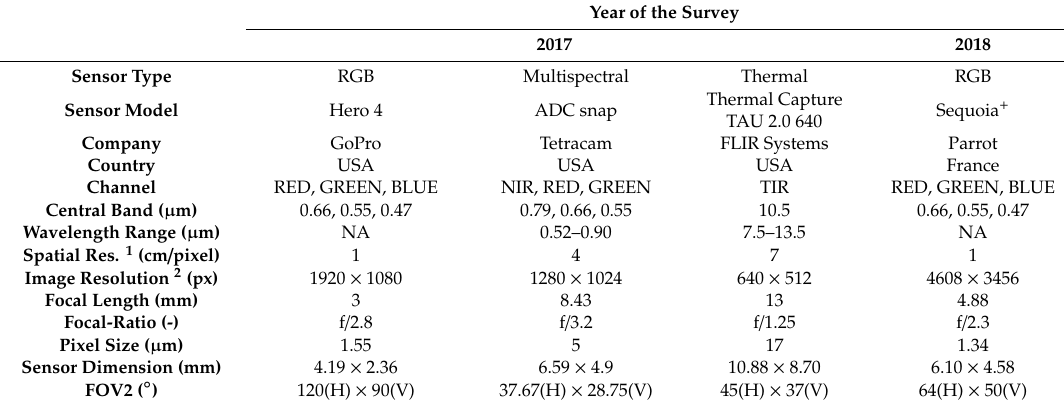
Table 1. Manufacturer technical specifications of the sensors used in the